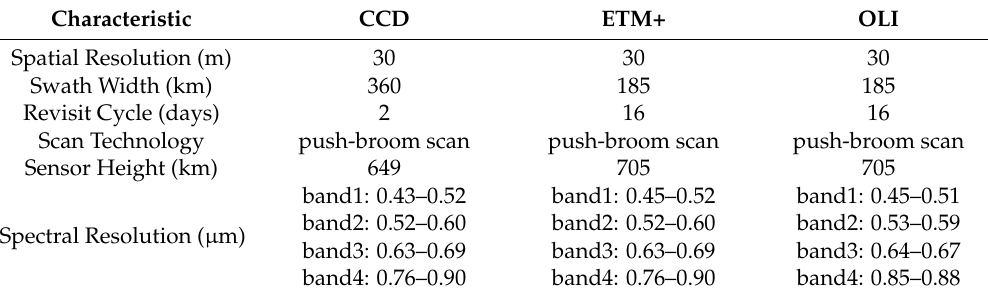
Table 2. Comparison of Sensor specifications of Charged-Coupled Device (CCD), ETM+, and